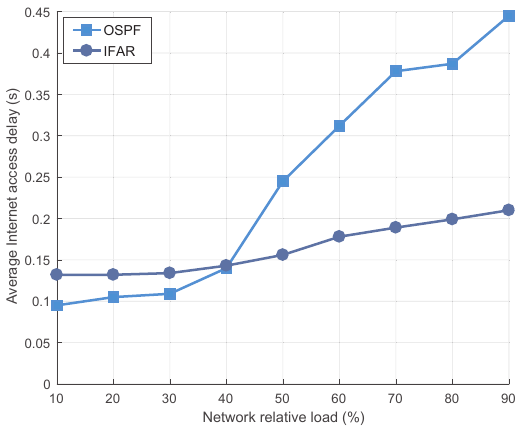
Figure 6. The average internet access latency of users under different network